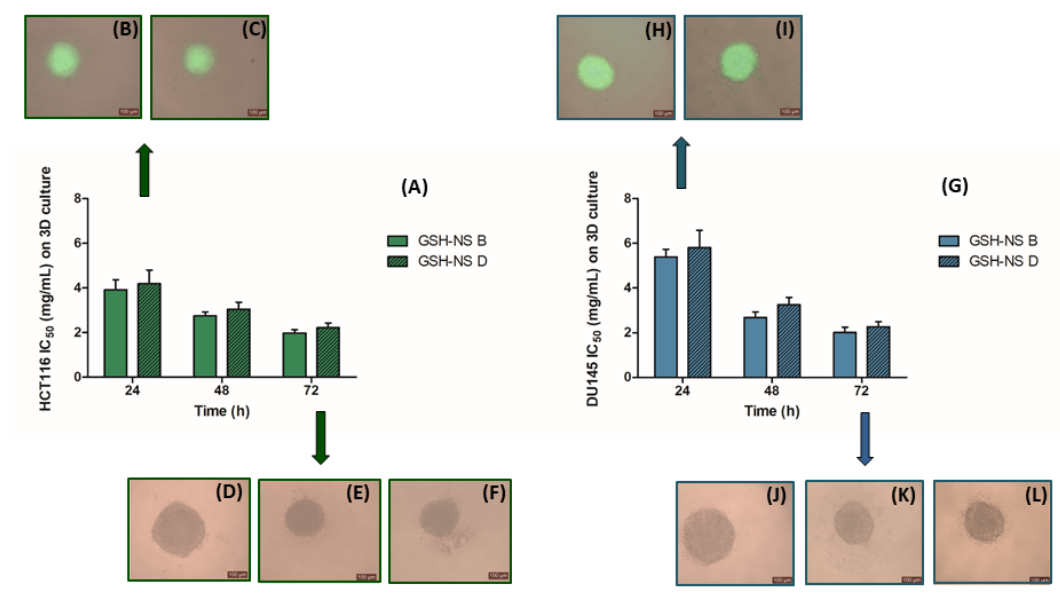
Figure 6. Glutathione responsive β -cyclodextrin-based nanosponge cytotoxicity and uptake on 3D